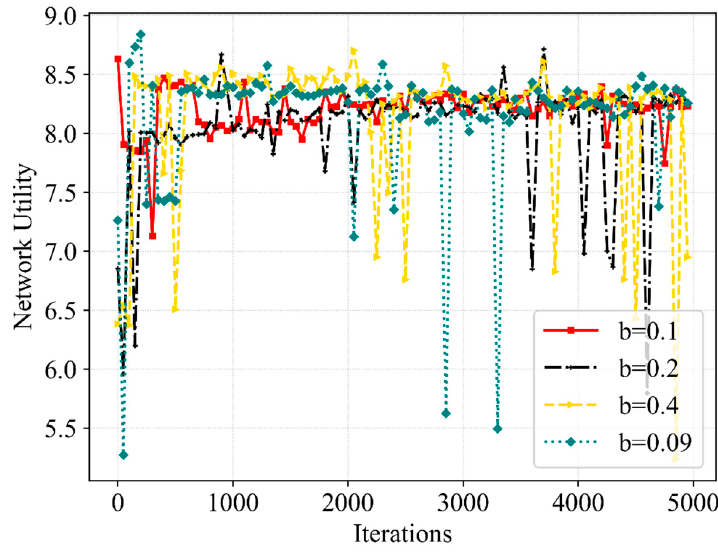
Figure 14. A comparative result of network utility at various 𝑏 .